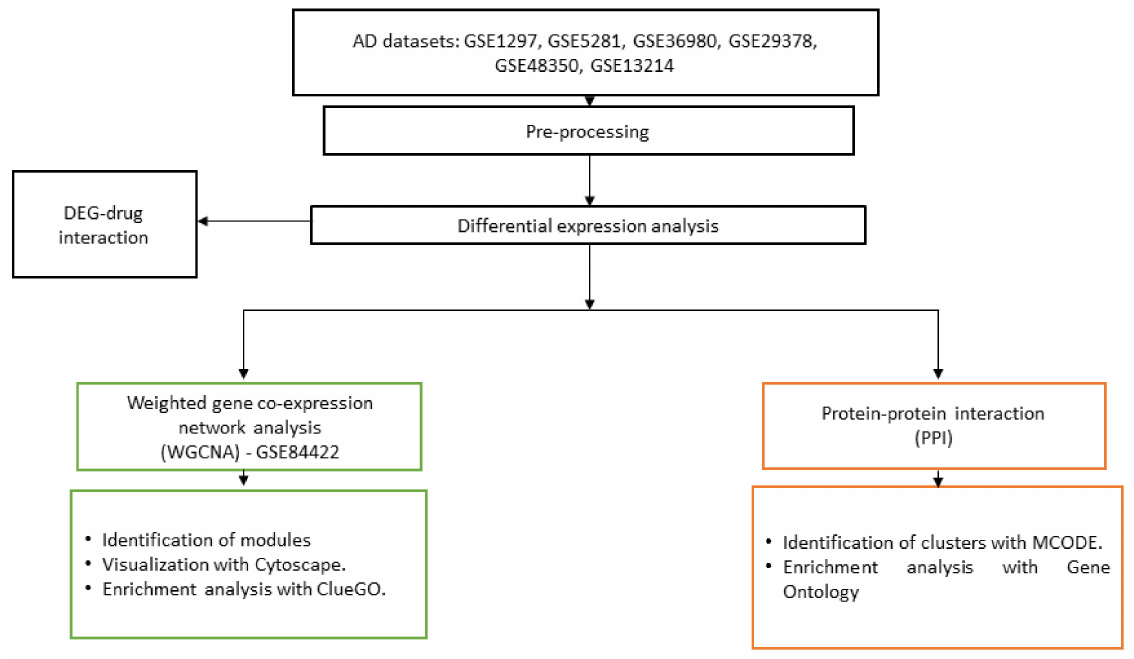
Figure 1. Computational